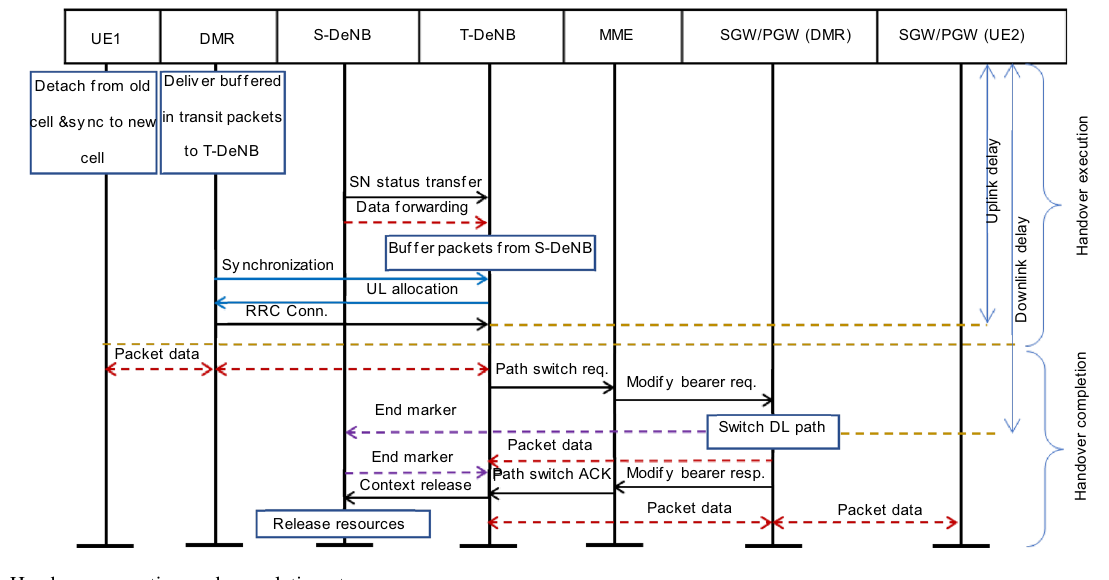
Fig. 5 Handover execution and completion